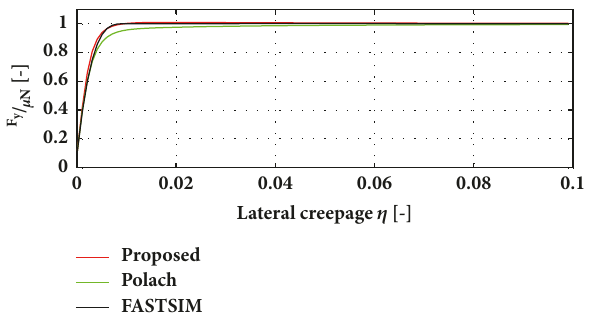
Figure 9: Lateral force versus lateral creepage in presence of a constant spin creepage ( 𝜙 = 0.1).